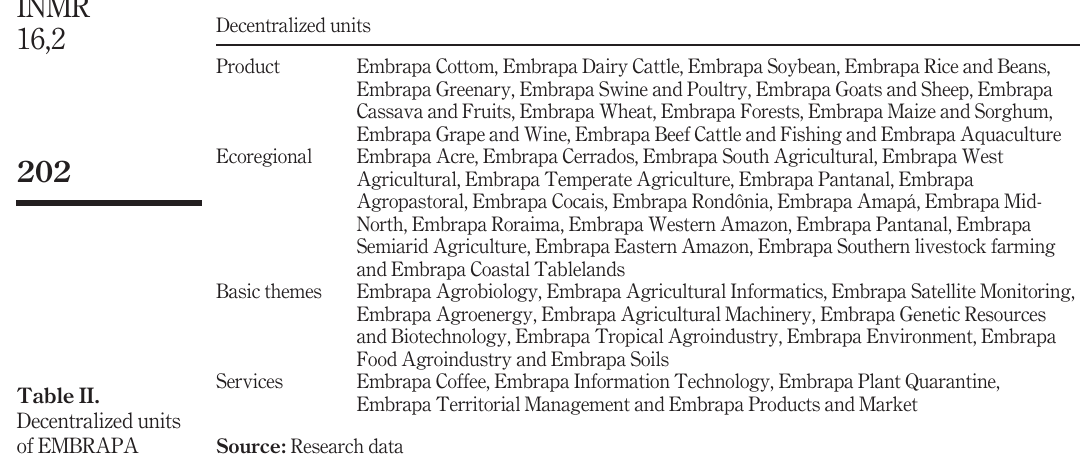
Table II. Decentralized units of EMBRAPA